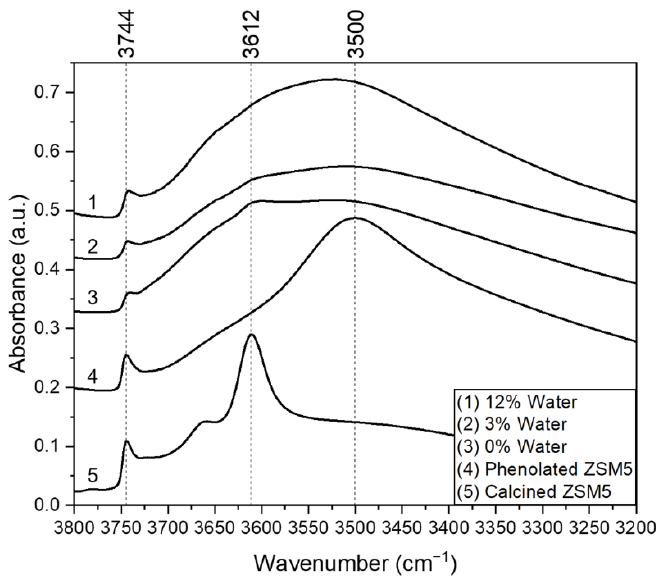
Figure 7. Infrared spectra in the hydroxyl region of ZSM-5 after reaction with various water con- tent (1 – 3), with gaseous phenol adsorbed (4) and post calcination (5) spectra included for refer- ence.